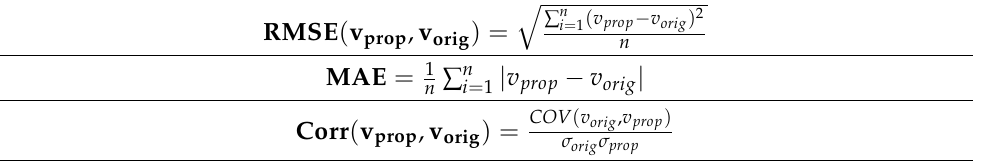
Table 2. Different error